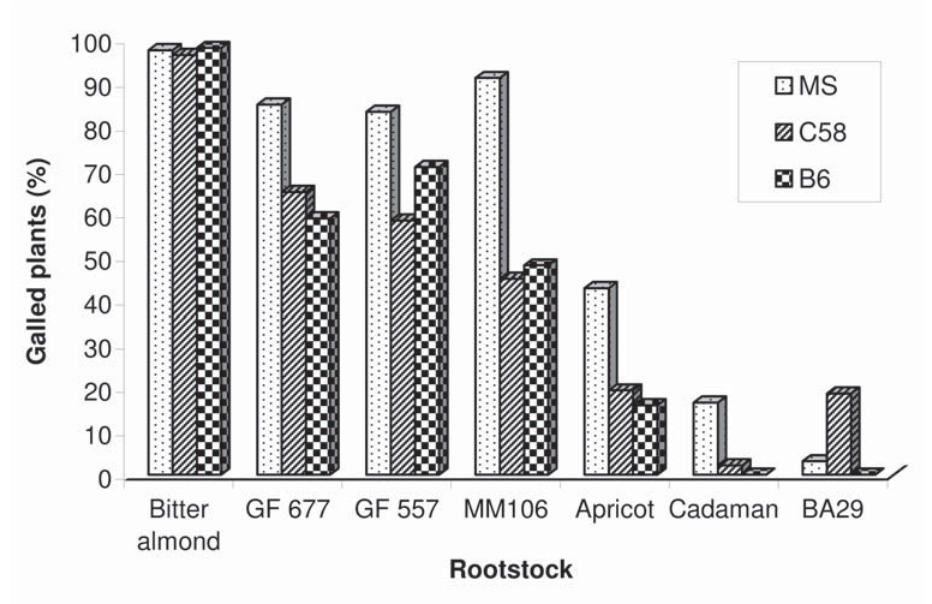
Fig. 3. Percentages of galled plants after root inoculation of rootstocks with A. tumefaciens strains MS, C58 and B6 (experiments in